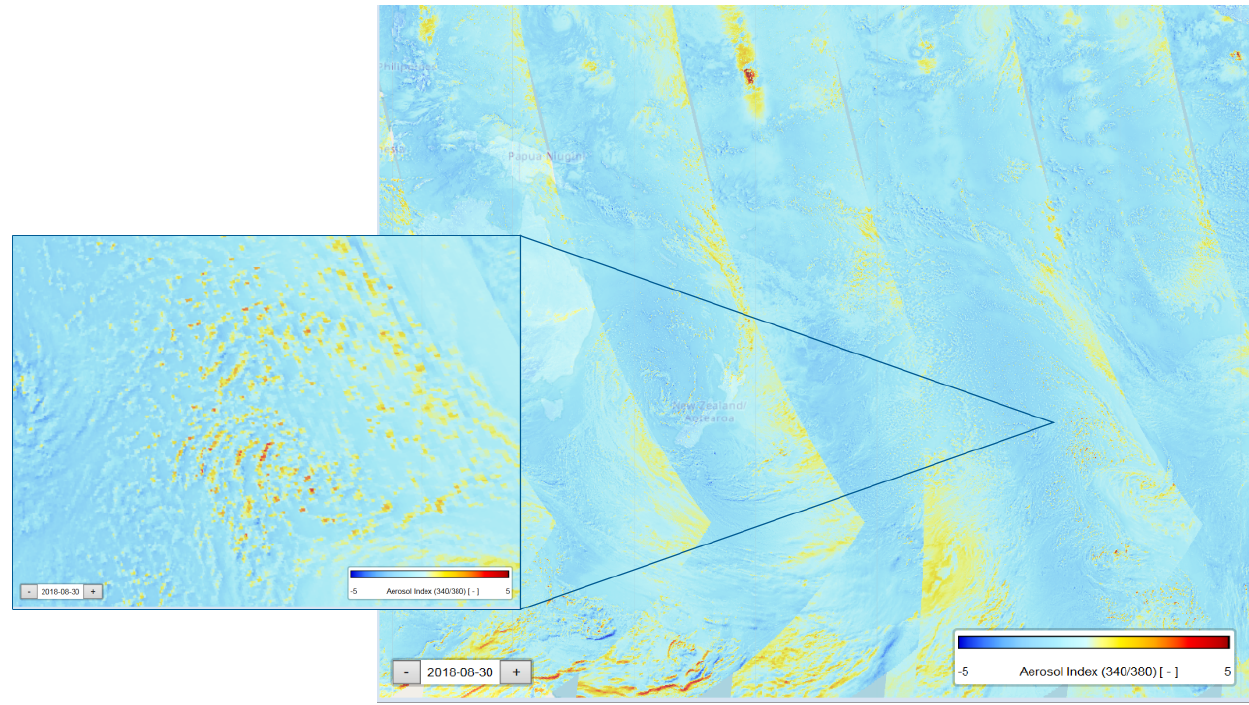
Figure 1. Example of small-scale effects of clouds on the TROPOMI AAI over the South Pacific Ocean. This scene was observed on 30 August 2018 (orbit 4563). The large area, about 6000km × 5000km centered at around 35 ◦ S, 170 ◦ W, contains scattered clouds showing positive (red) and negative (blue) AAI values. The size of the zoomed in area is about 920km ×